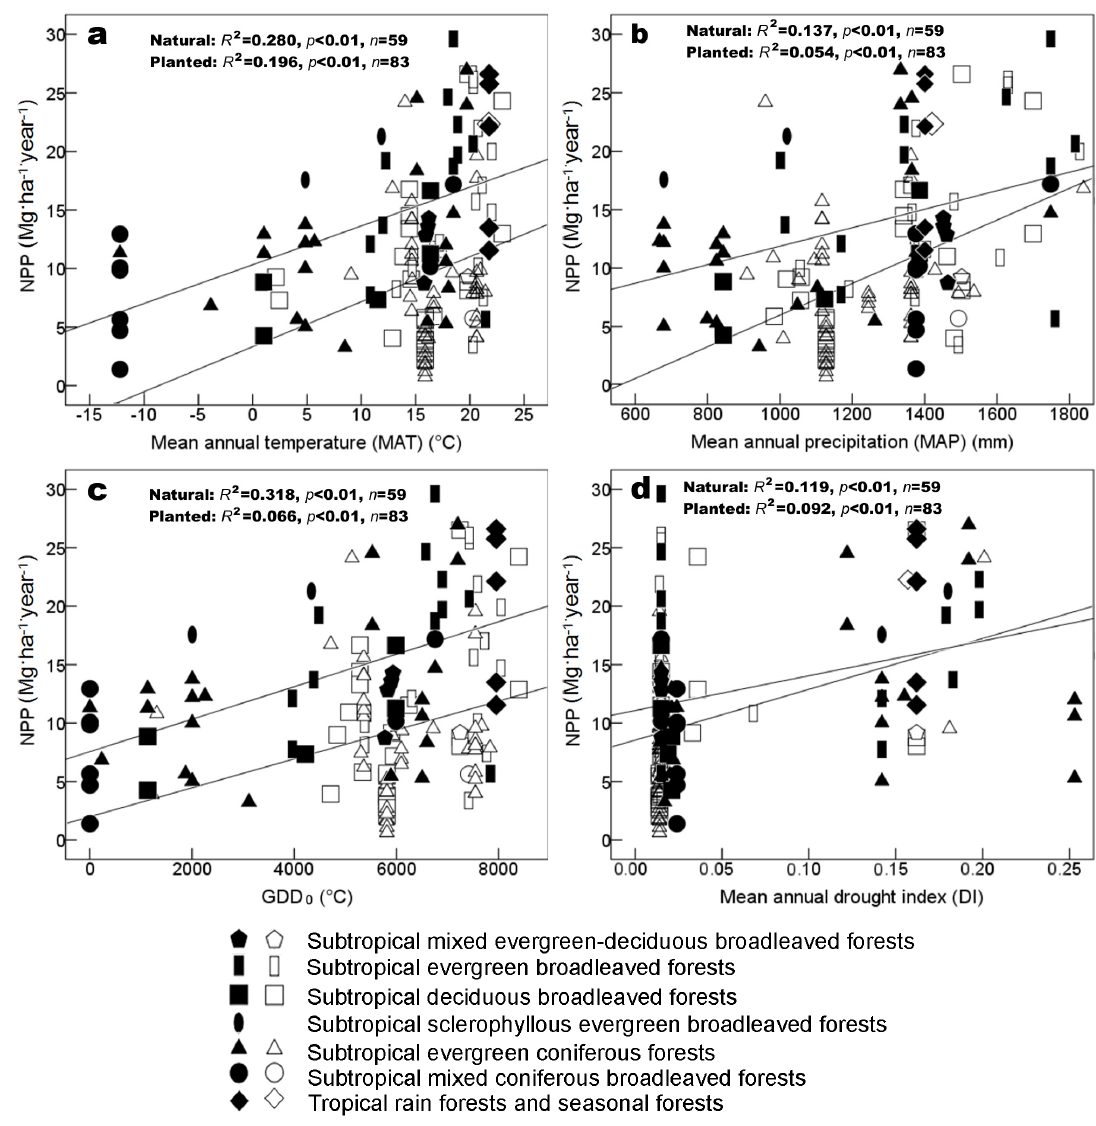
Figure 6. Relationships between NPP and climate factors. Solid symbols: NPP of natural forests; hollow symbols: NPP of planted forests. ( a ) MAT; ( b ) MAP; ( c ) GDD 0 ; and ( d ) DI.